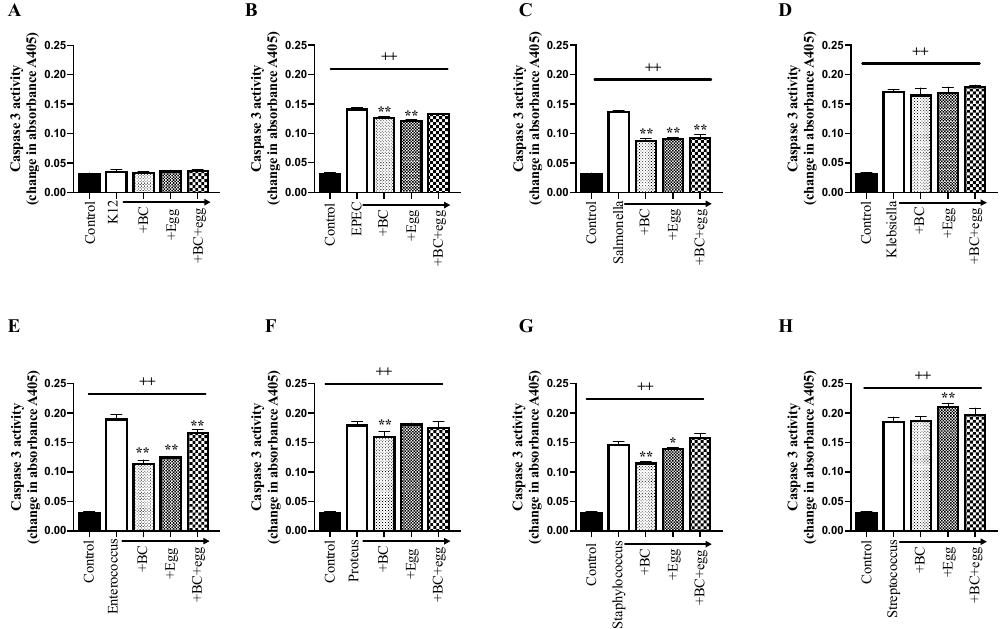
Figure 4. Effect of BC, egg, or the combination on active caspase-3. Bacterial strains (1 × 10 6 CFU/well) ± BC (1 mg/mL), egg (1 mg/mL), or the combination (0.6 mg/mL BC + 0.4 mg/mL egg) were added to confluent monolayers of Caco-2 cells. Cleared lysates were prepared 24 h later. Control wells received no bacteria or test product. ( A ) E. coli K12 (negative control); ( B ) EPEC; ( C ) Salmonella ; ( D ) Klebsiella ; ( E ) Enterococcus ; ( F ) Proteus ; ( G ) Staphylococcus ; ( H ) Streptococcus. Results are expressed as mean ± SEM from 3 wells. ++ signifies p < 0.01 vs. non treated (without bacteria or test product) control and * & ** signify p < 0.05 & 0.01 vs. bacteria alone.